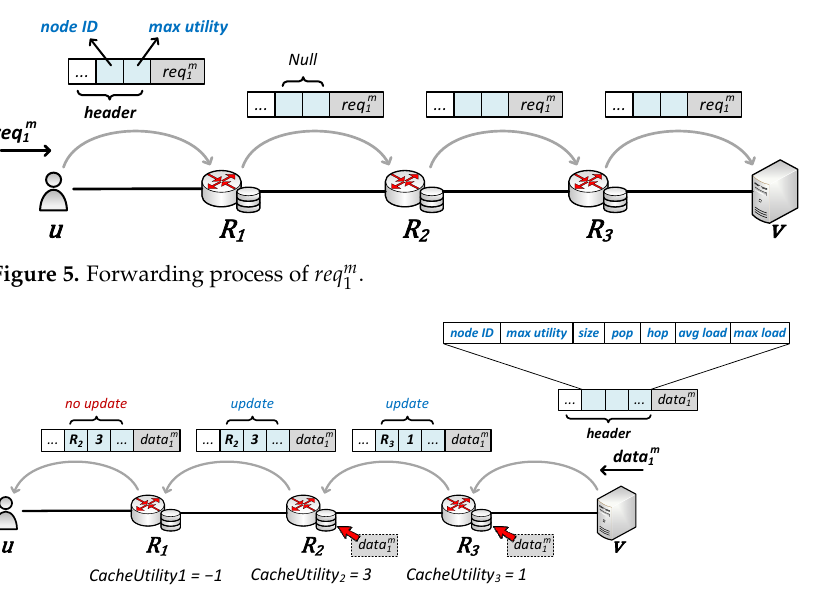
Figure 6. Forwarding process of 𝑑𝑎𝑡𝑎 (cid:2869)(cid:3040) .